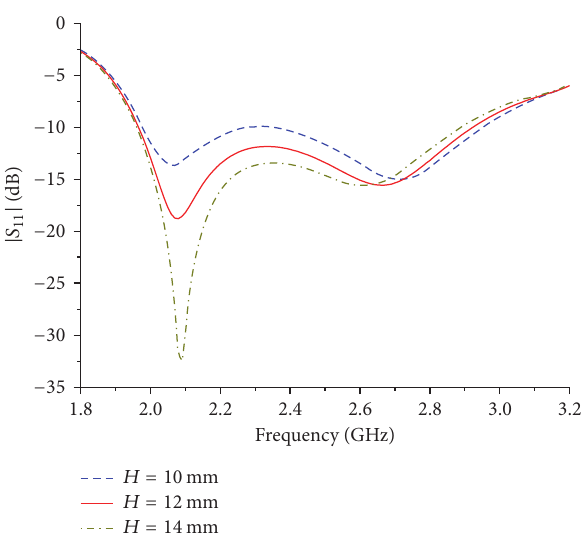
Figure 9: Simulated |𝑆 11 | of the proposed dual-polarized antenna with different number of AMC